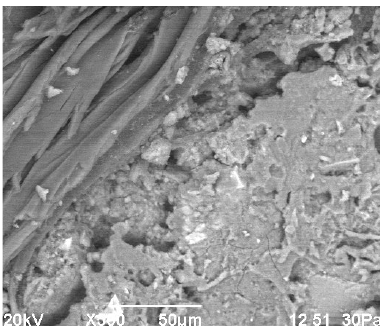
Fig. 7. Microstructure of the contact zone of the composite.